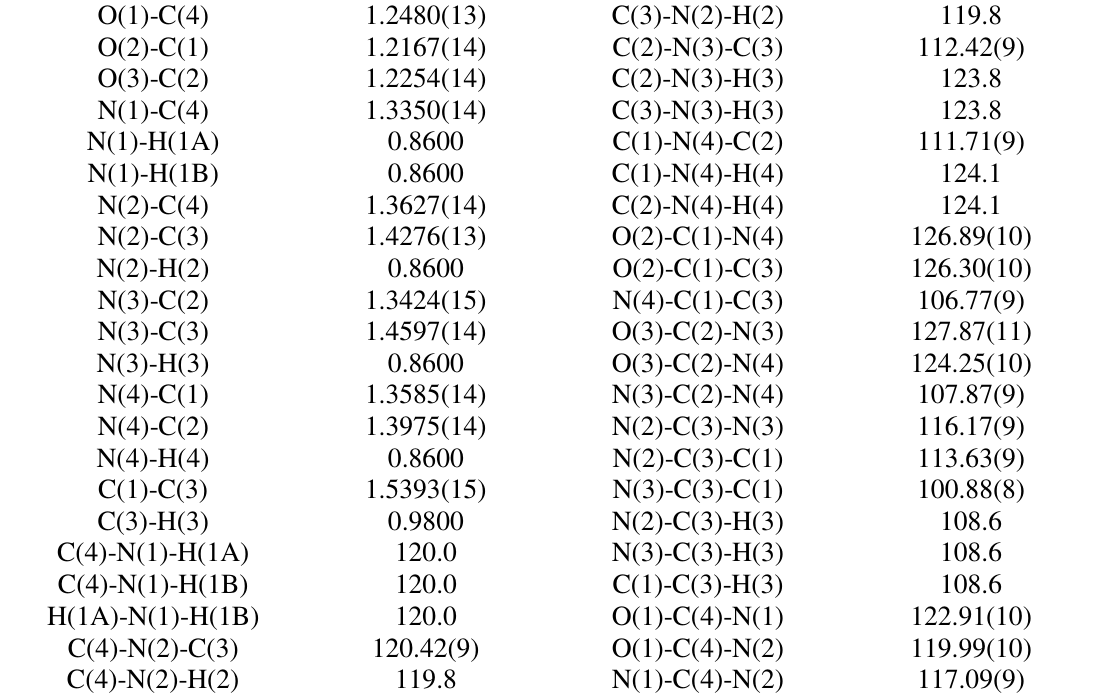
Table 1. Bond lengths [Å] and angles [°] for allantoin from U. esculenta .